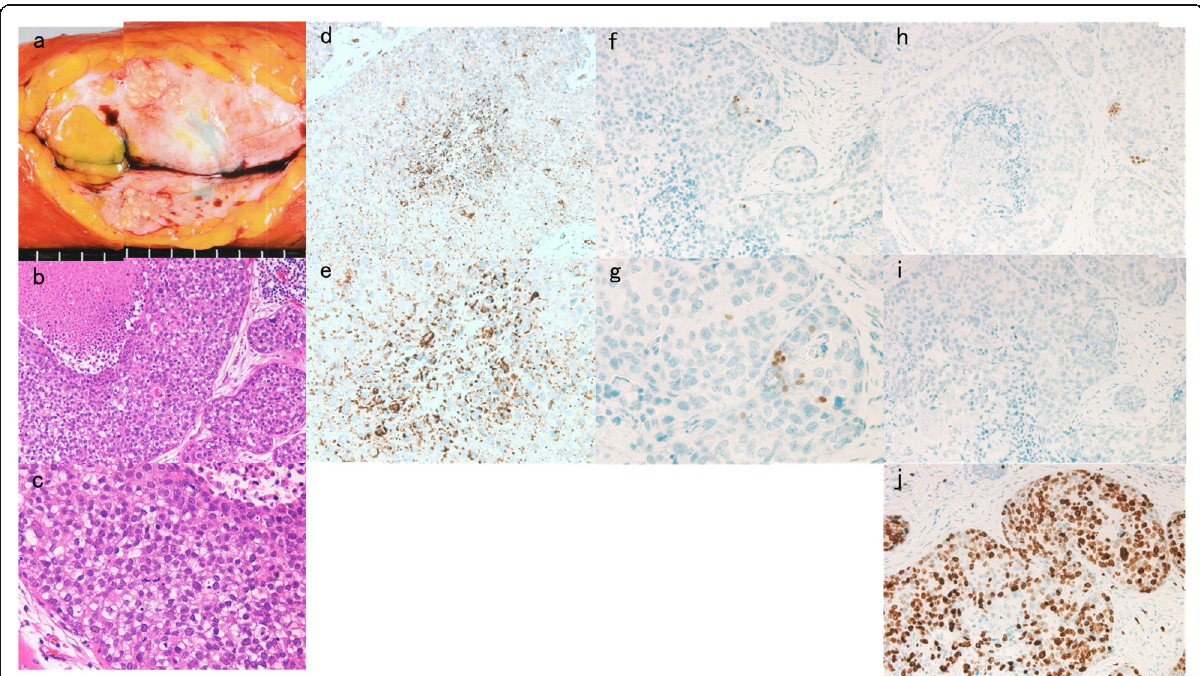
Fig. 5 Macroscopic and pathological findings. a Macroscopic analysis showing relatively clear boundaries. A localized yellowish, white mass was observed, and continuity between the skin and papilla was not evident. b Histopathological analysis revealed carcinoma in situ as the dominant lesion. Hematoxylin and eosin staining revealed cytoplasmic clear and minute vacuolar structures of numerous tumor cells, indicating sebaceous differentiation. c Higher magnification of b . d Most tumor cells (50 – 90%) were adipophilin-positive. e Higher magnification of d . f – i Tumor cells did not detectably express estrogen receptor (ER), f progesterone receptor (PgR) (h), or human epidermal receptor 2 (HER2) ( i ). g Higher magnification of f . j The Ki 67 labeling index was